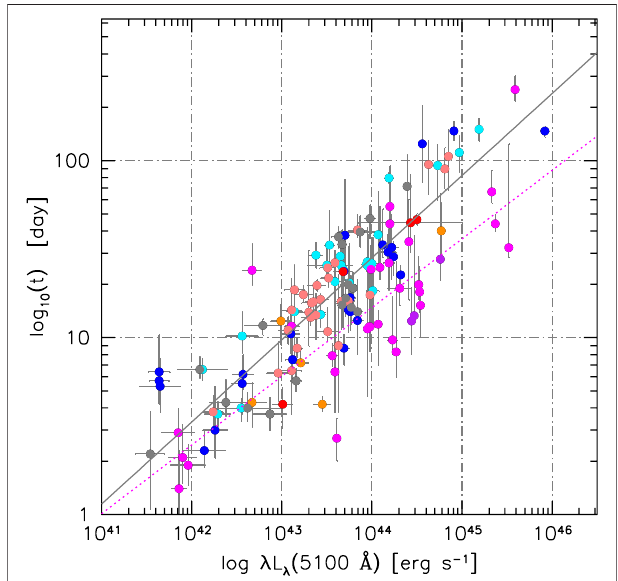
FIGURE 10 | The radius-luminosity relation, expressed as the relation between the time lag derived from reverberation mapping and the optical luminosity. Data are from Du and Wang (2019), and include, in addition to the sources of Bentz et al. (2013) also the xA sources monitored in dedicated campaigns (Du et al., 2016a; Du et al., 2018a). Sources are color coded according to the spectral types identi fi ed along the quasar main sequence: B1 ++ (red), B1 + (orange), B1 (rose), B2 (gray), A1 (aquamarine), A2(blue), A3(magenta), A4(purple), and roughlycorrespond toasequence of increasing Eddington ratio. The gray line traces an unweighted least square fi t for the full sample, the dotted magenta line refers to an unweighted lsq but for sources radiating at extreme Eddington ratios (A3 and A4) only.